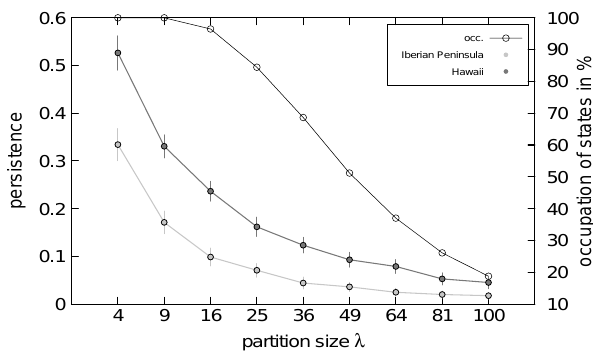
Fig. 7. Persistence of the regional climate systems of Hawaii (dark grey) and the Iberian Peninsula (light grey). From partition size λ = 16 full occupation of the states of the transition matrix cannot be fulfilled.